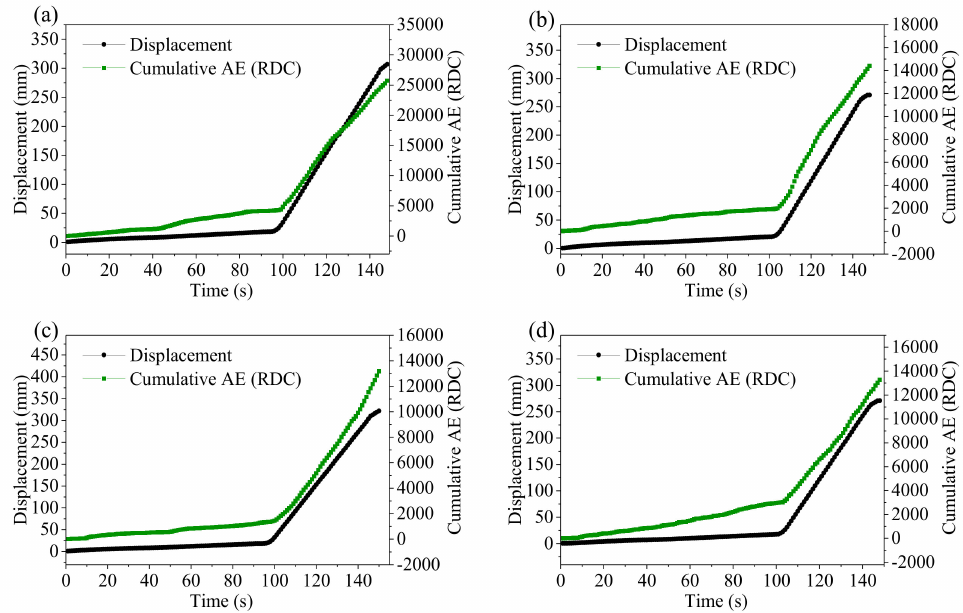
Figure 12. Displacement and cumulative ring down count (RDC) plotted against time in ( a – d ) for the four experiments. All data points are the moving average value of 5 s.